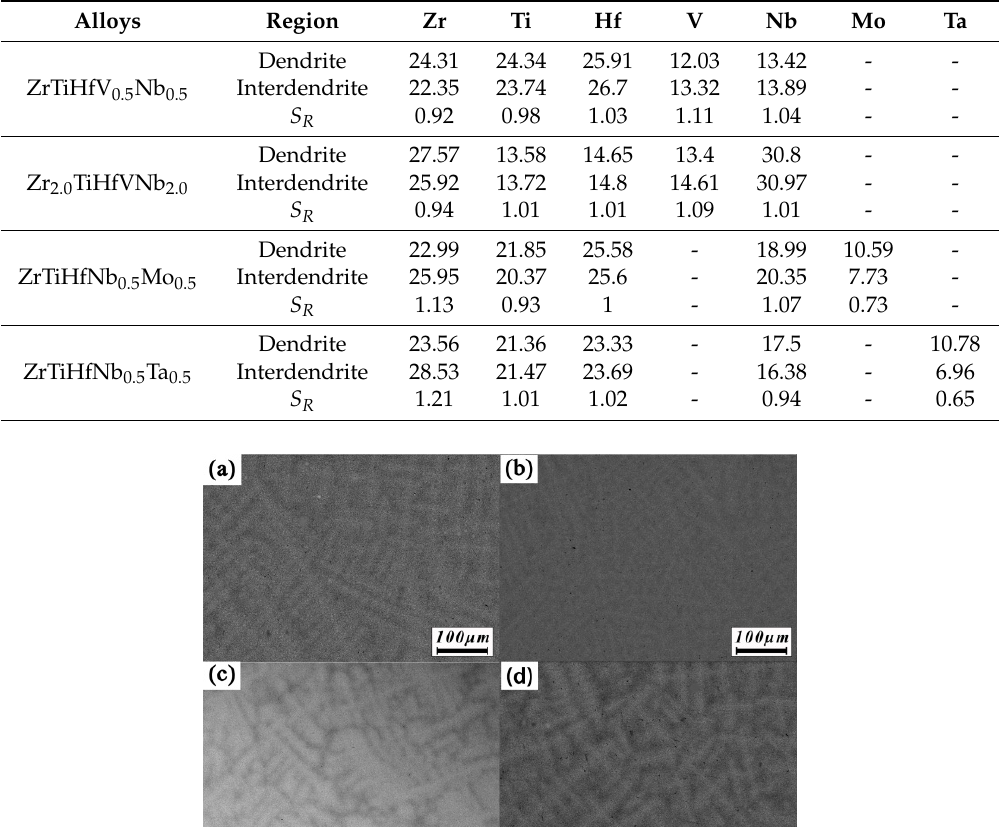
Table 2. The components analysis of the RHEAs.